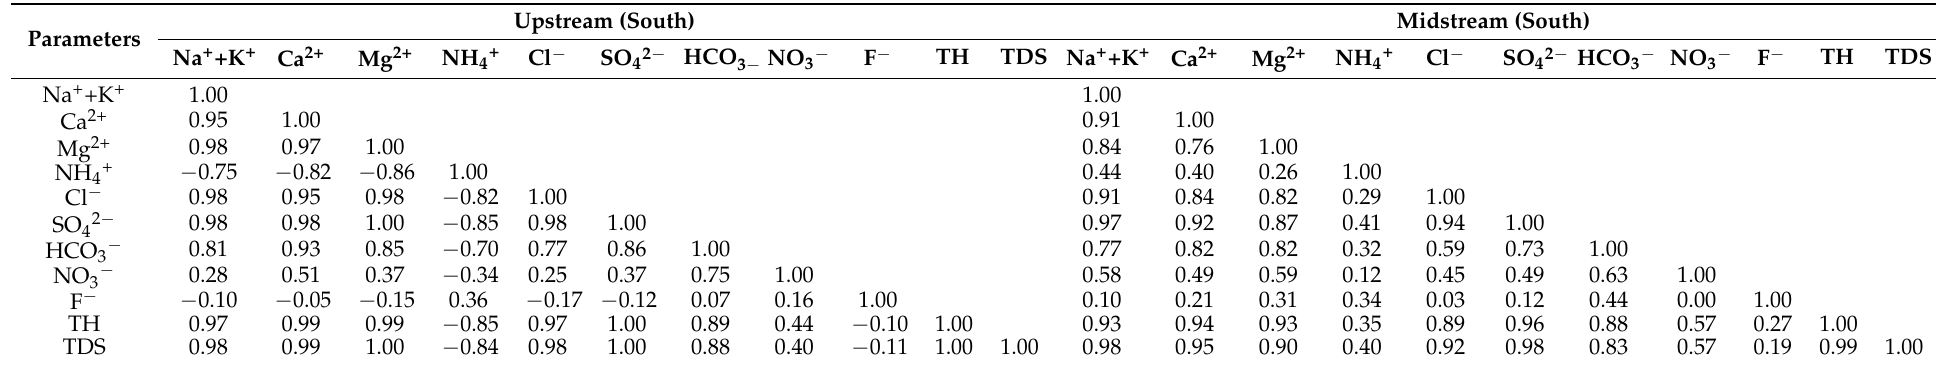
Table 3. Matrix of coefficient of correlation in the southern basin.